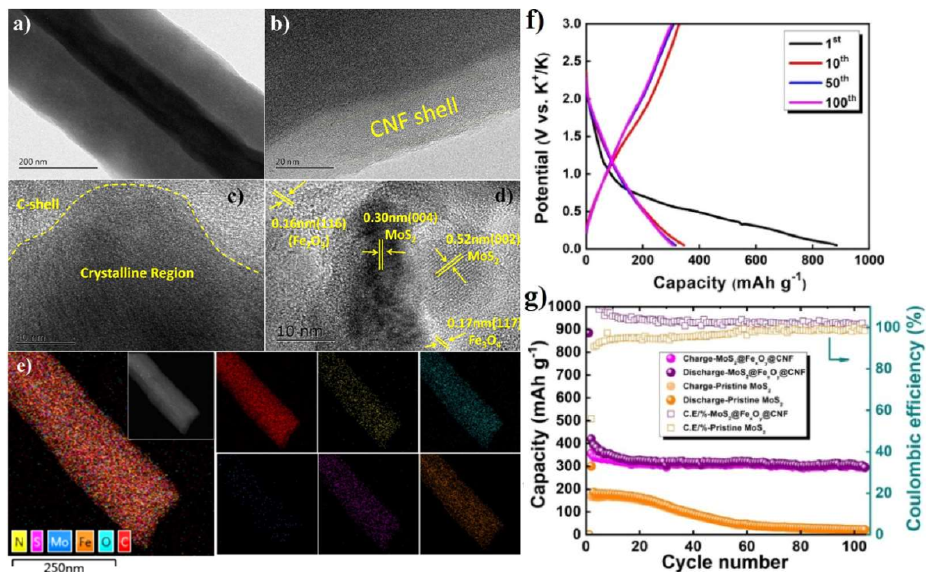
Figure 9. ( a ) Low magnification transmission electron microscopy (TEM) of an electrospun core- shell MoS 2 @Fe x O y @CNF. ( b ) High resolution TEM (HRTEM) image of the MoS 2 @Fe x O y @CNF